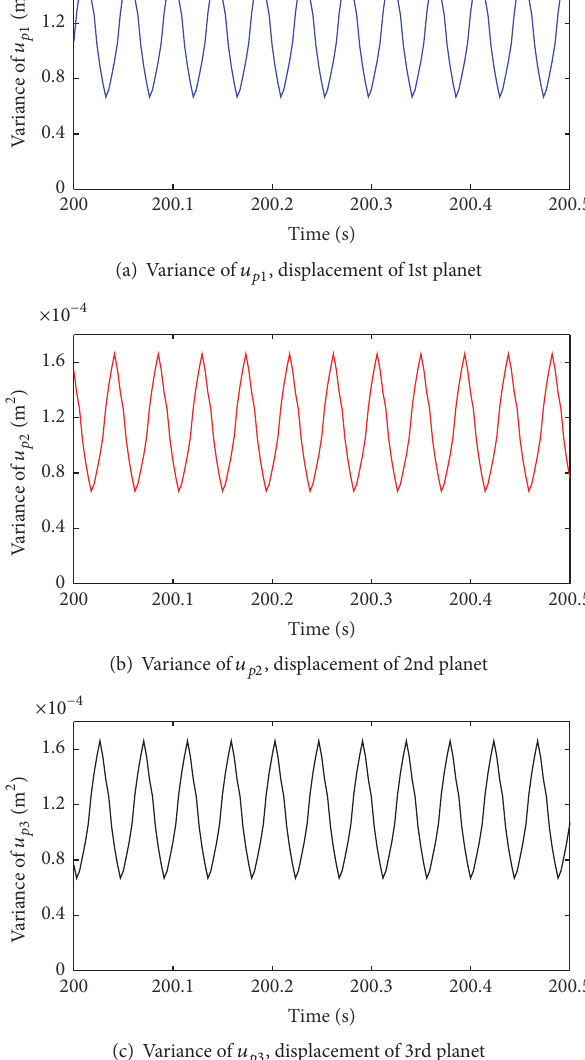
Figure 4: Variances of the sun gear: (a) variance of 𝑧 𝑠 ; (b) variance of 𝑦 𝑠 ; (c) variance of 𝑑 𝑠 .